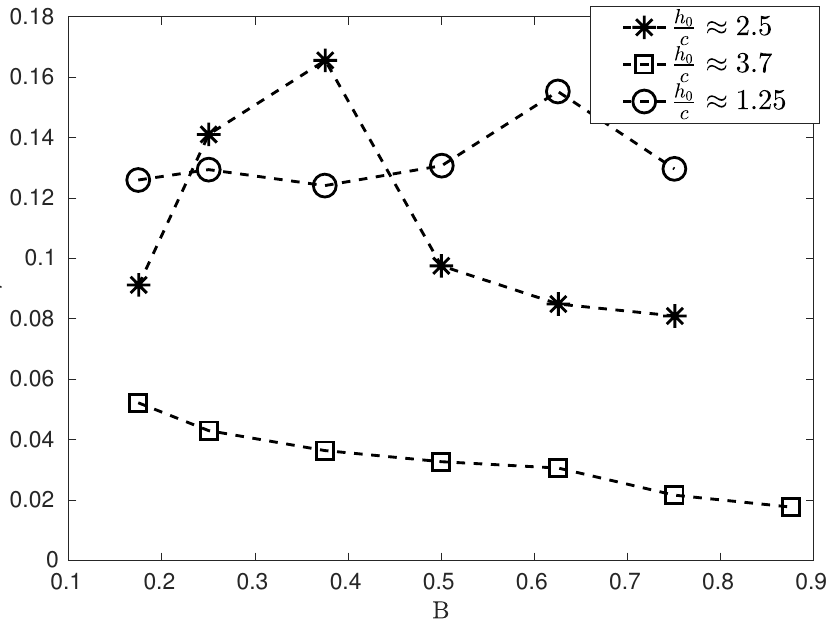
Figure 9. η vs. B . Same as in Figure 7, if the “turn around” of the foil was made passively ( Re = 2 × 10 4 ). The markers correspond to different values of h 0 / c : circles: h 0 / c = 1.25; squares: h 0 / c = 3.75; and, asterisks: h 0 / c =